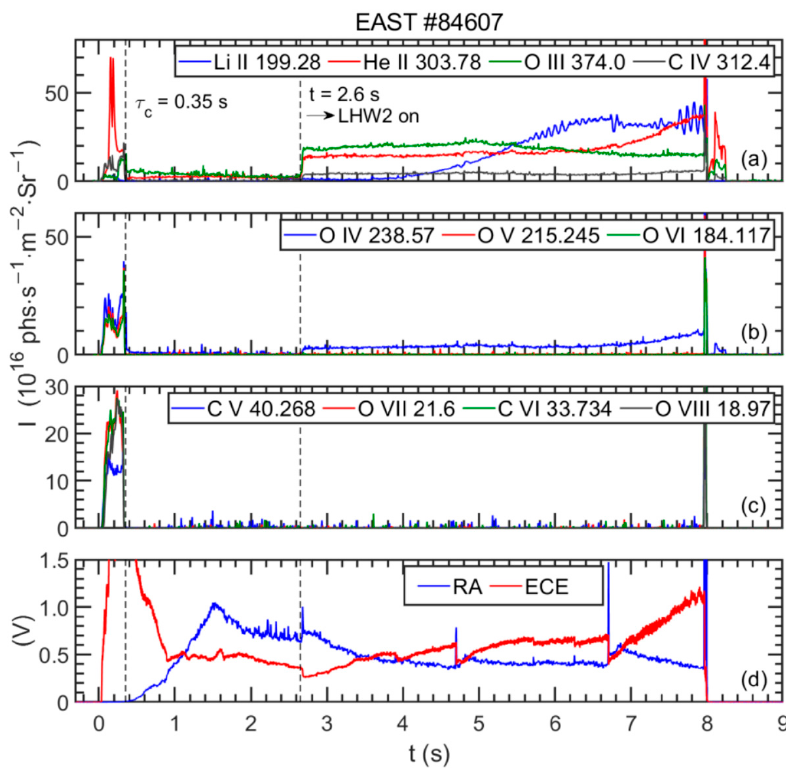
Figure 7. Time traces of spectral lines intensity with lithium granule injection (#84607, recovery discharge). ( a ) Li II 199.28 Å, He II 303.78 Å, O III 374.0 Å, and C IV 312.4 Å, ( b ) O IV 238.57 Å, O V 215.245 Å, and O VI 184.117 Å, ( c ) C V 40.268 Å, O VII 21.6 Å, C VI 33.734 Å, and O VIII 18.97 Å, ( d ) runaway electrons and ECE signal. Lithium granule entered plasma at t = 3.6 s in this discharge.